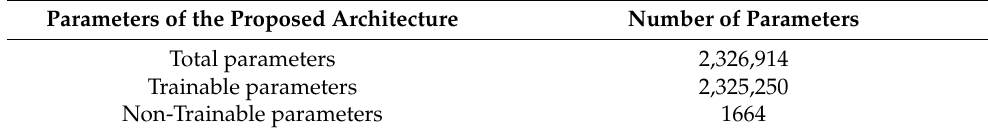
Table 1. The overall number of parameters of our suggested architecture. Parameters of the Proposed